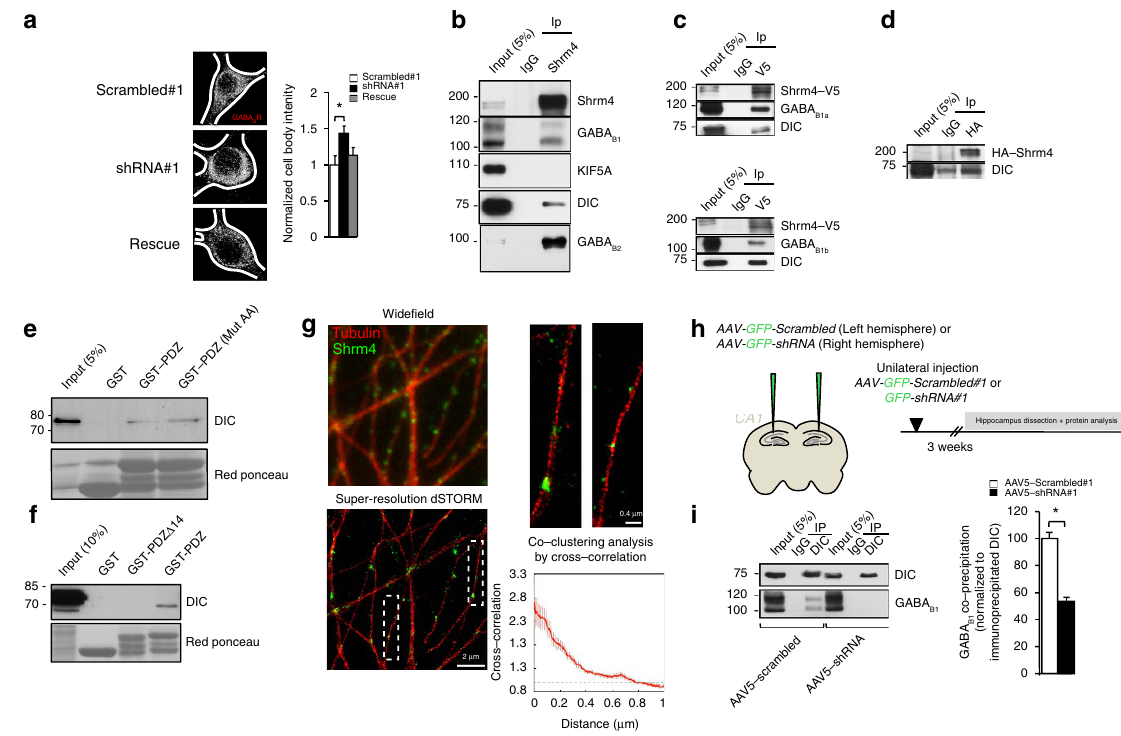
Figure 3 | Shrm4 links GABA B Rs to the dynein/dynactin complex. ( a ) Immunofluorescence of GABA B R intensity in the cell body of 18 DIV cultured hippocampal neurons transfected with Shrm4 scrambled#1, knockdown (shRNA#1) or rescue constructs at 8 DIV . All data in bar graphs throughout are means ± s.e.m.; n ¼ 10, 10, 15 * P ¼ 0.0057; F(2,32) ¼ 6.094, one-way ANOVA-Mann–Whitney. ( b ) Co-immunoprecipitation experiments on brain extracts using polyclonal anti-Shrm4 show that Shrm4, GABA B1 , GABA B2 and DIC are associated. By contrast, KIF5A is not present in this complex. ( c ) Co-immunoprecipitation of both GABA B1 isoforms in HEK293 cells transfected with Shrm4-V5 and GABA B1a -myc (top) or GABA B1b -myc (bottom). GABA B1a , GABA B1b and the endogenous DIC co-immunoprecipitated with Shrm4-V5. ( d ) Endogenous DIC co-immunoprecipitates with expressed HA- Shrm4 in HEK293 cells in the absence of GABA B1a or GABA B1b subunits. Monoclonal antibodies (anti-V5, anti-myc and anti-DIC) were used for western blot. ( e ) Western blot from in vitro pull-down assay of purified Histidine-tagged DIC using GST-PDZ and mutant GST-PDZ (AA). The Shrm4-PDZ domain is able to directly bind DIC even when its common binding site is mutated. Ponceau Red staining of the blot has been presented at the bottom. ( f ) GSTpull- down experiments on brain extracts show that the Shrm4-PDZ domain pulls down DIC while the mutant GST-PDZ D 14 does not. Ponceau red staining of the blot has been presented at the bottom (full blot in Supplementary Fig. 11). ( g ) Conventional (top left) and super-resolution direct stochastic optical reconstruction microscopy (dSTORM) (bottom left) imaging of Tubulin-ATTO 488 (shown in red) and Shrm4-Alexa 647 (shown in green). Shrm4 positive puncta are localized along microtubule-positive filaments, as evidenced in the details of the super-resolution image (top right). The super-resolution data has been quantified by cross-correlation analysis. The positive, higher than 1 cross-correlation, indicates co-clustering of the two fluorescent signals (Error- bars are s.e.m.s, number of regions for the cross-correlation measurement: 30, number of fields: 3. Scale bar, 0.4 m m). ( h ) Schematic illustrating unilateral local injection of AAV5-scrambled#1 (left hemisphere) and AAV5-shRNA#1 (right hemisphere) into rat brain CA1 hippocampus, with time line for recovery and experiments. ( i ) Western blots and histograms showing monoclonal anti-DIC immunoprecipitation from scrambled and shRNA lysates of infected hippocampus extracts ( n ¼ 6 rats). Co-precipitated GABA B1 levels were normalized to DIC immunoprecipitation levels and the normalized percentage of GABA B1 co-precipitation was calculated. Histograms show mean ± s.e.m.; * P o 0.05, t